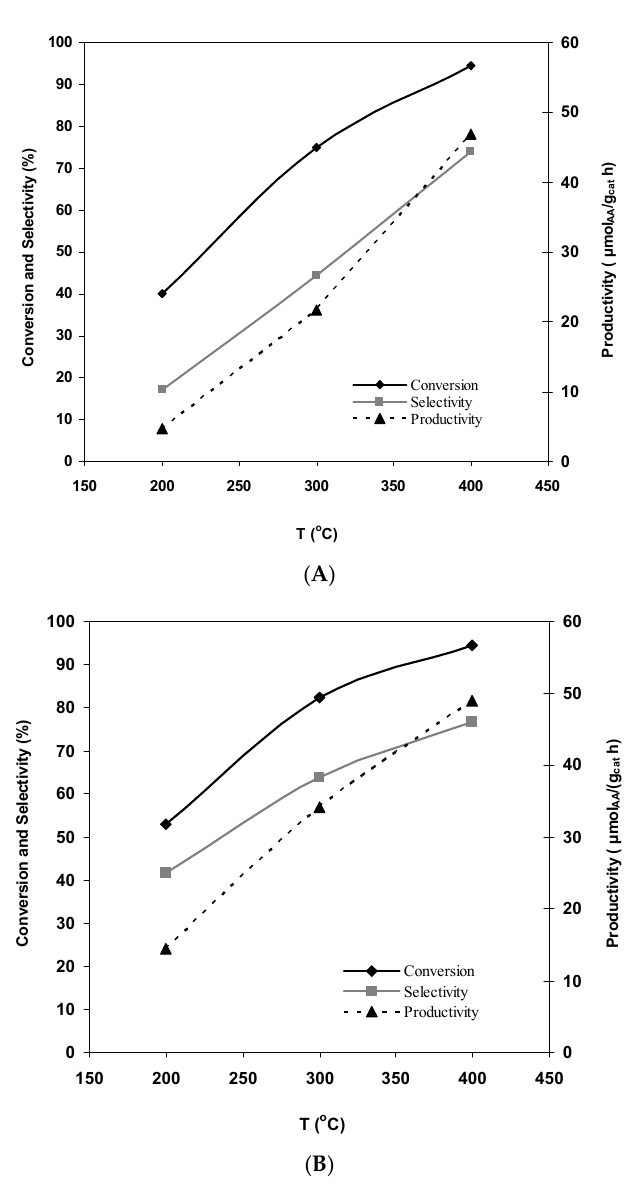
Figure 1. Dependence of the parameters of the process of ethanol conversion on the reaction temperature under thermal ( A ) and microwave ( B ) heating of the catalyst with the composition (wt %) ZnO-22.8; CuO-58.8; SiO 2 -9.2; WC-9.1.